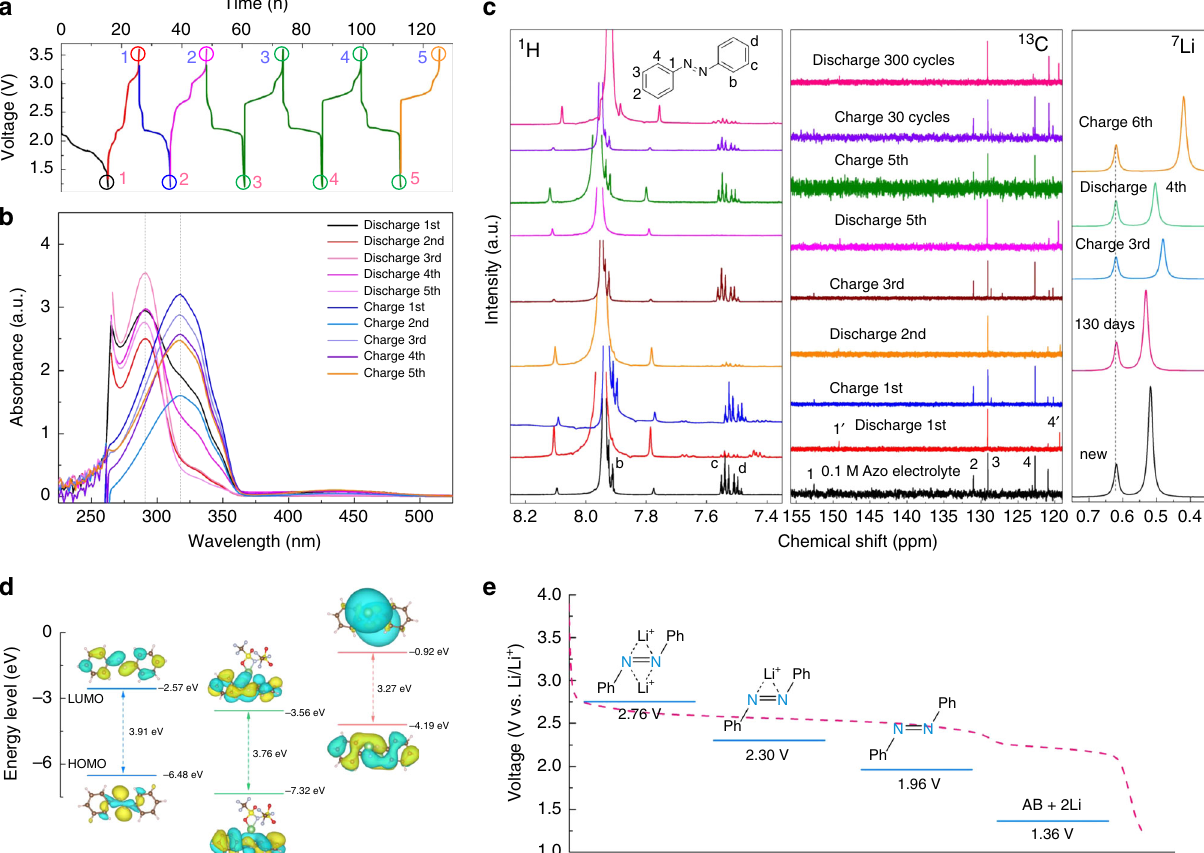
Fig. 6 Characterization of electrochemical reversibility and reaction mechanism. Charge and discharge pro fi les of 0.1 M AB electrolyte over time at the current density of 0.05 mA cm − 2 ( a ) and corresponding UV – vis spectra recorded at different charge and discharge state ( b ). c 1 H, 13 C, and 7 Li NMR spectra of 0.1 M AB electrolyte measured at various selected charge and discharge cycles. d Optimized structure and calculated energy levels of AB, AB- LiTFSI, and Li 2 AB obtained from DFT simulations. e Comparison between the discharge voltage curve after the voltage evolution and predicted voltages of AB in different coordination con fi